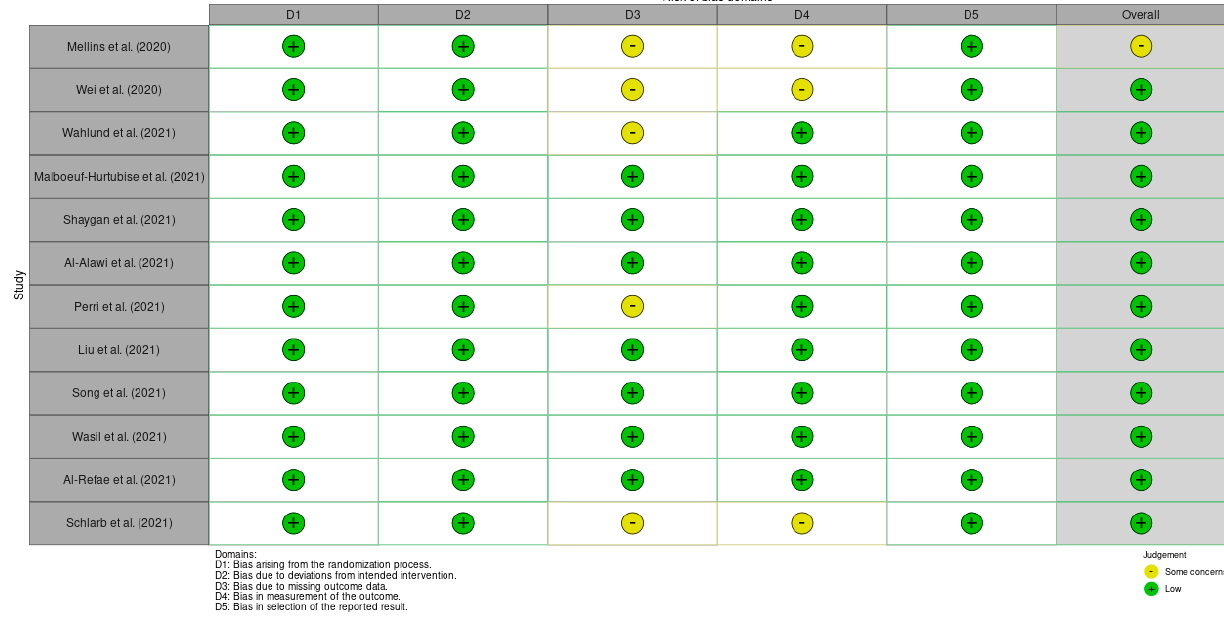
Figure 2. Risk of bias in included studies.